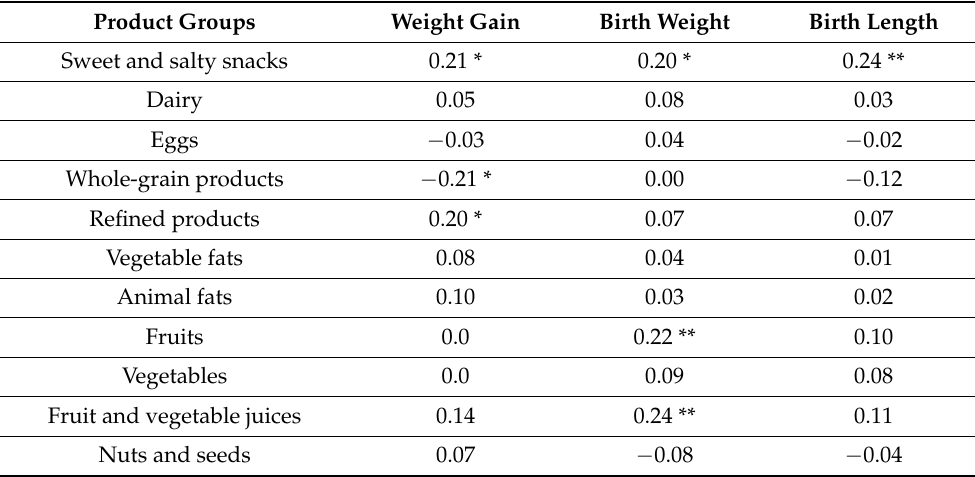
Table 3. Spearman’s correlation of the food consumption frequency and maternal weight gain during pregnancy and newborn weight and length ( n =